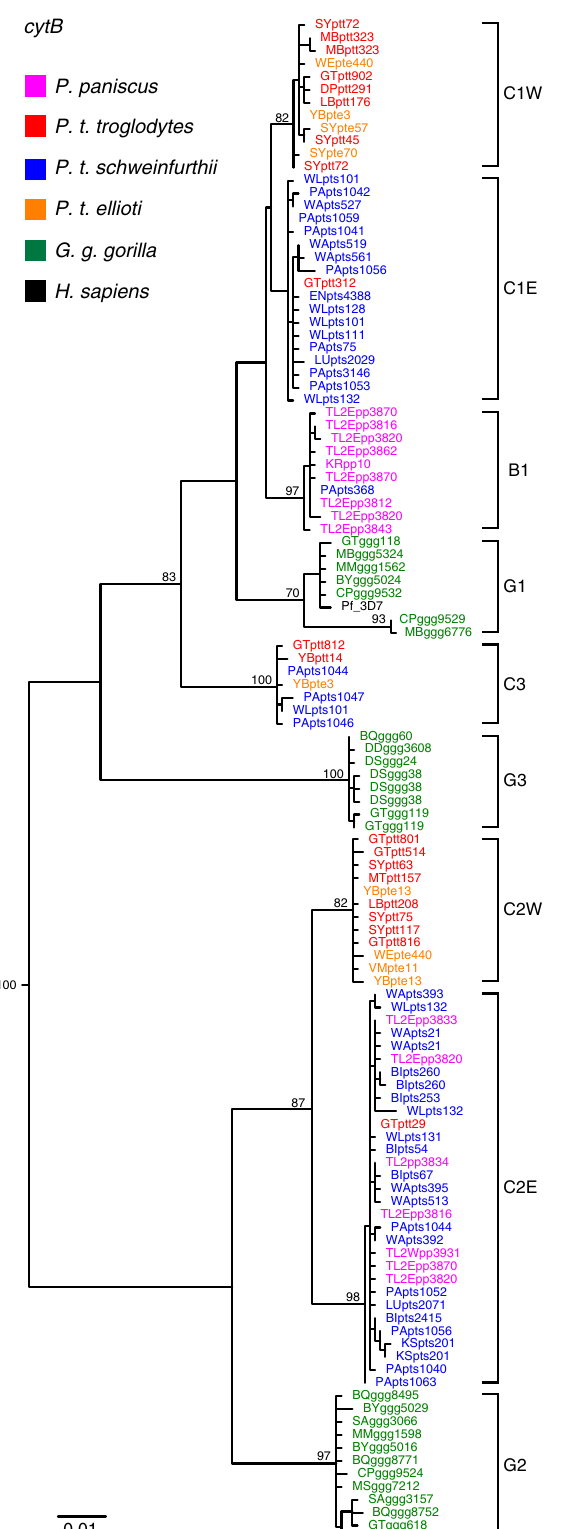
Table 3), none of the newly derived cytB sequences fell within the B1 clade (Supplementary Table 4). Instead, eastern chimpan- zees were exclusively infected with P. reichenowi (C1), P. gaboni organelle and nuclear loci for analysis (Supplementary Table 2). These included 3.4 and 3.3 kb mitochondrial DNA (mtDNA) fragments, which together span the entire mitochondrial genome; a 390 bp caseinolytic protease M ( clpM) gene fragment from the apicoplast genome; and three nuclear loci, including portions of genes encoding the erythrocyte binding antigens 165 ( eba165; 790 bp) and 175 ( eba175; 394 bp), and the gametocyte surface protein P47 ( p47; 800 bp). Phylogenetic analyses of 134 newly derived parasite sequences yielded very similar results (with respect to the clustering of parasites into major clades) in all genomic regions (Fig. 3 and Supplementary Fig. 2). Except for a single C1 eba175 sequence indicative of a rare P. reichenowi infection (Supplementary Fig. 2d), all other bonobo-derived sequences fell either within P. gaboni or the B1 clade (Supplementary Table 2). This new clade was supported by high bootstrap values in all genomic regions analysed, except for the short eba175 fragment. It also consistently grouped as a sister clade to P. reichenowi . These fi ndings, along with the extent of genetic divergence between P. reichenowi and the newly identi fi ed bonobo parasite clade, argue strongly for the existence of an additional Laverania species that is speci fi c for bonobos (Figs. 2 and 3 and Supplementary Figs. 1 and 2). The fi nding of B1 cytB (Fig. 2) and eba165 (Fig. 3a) parasite sequences in a single chimpanzee faecal sample collected 280 km east of TL2 does not argue against this, since it shows that B1 parasites reached this geographic region, but failed to spread in the resident chimpanzee population (Supplementary Table 4). We propose to name the new bonobo parasite species Plasmodium lomamiensis sp. nov. to highlight its discovery in Lomami National Park, using faecal-derived mitochondrial, apicoplast and nuclear parasite sequences as the type material (Supplementary Data 1) 19 . Although classifying ape Laverania species solely on the basis of genetic information has been controversial 3,17,20 , there are no obvious alternatives given the endangered status of wild apes, the prevalence of mixed Laverania species infections (Supplementary Table 2) and the cryptic nature of these parasites 3,9,21 . Fig. 2 Relationship of bonobo parasites to ape Laverania species. A maximum likelihood tree of mitochondrial cytochrome B ( cytB ) sequences (956 bp) depicting the phylogenetic position of newly derived bonobo parasite sequences (magenta) is shown. Only distinct cytB haplotypes are depicted (the full set of SGA-derived bonobo parasite sequences is shown in Supplementary Fig. 1). Sequences are colour-coded, with capital letters indicating their fi eld site of origin (see Fig. 1 for location of fi eld sites) and lowercase letters denoting their host species and subspecies origin (ptt: P. t. troglodytes , red; pte: P. t. ellioti , orange; pts: P. t. schweinfurthii , blue; ggg: G. g. gorilla , green; pp: Pan paniscus , magenta). C1, C2 and C3 represent the chimpanzee parasites P. reichenowi , P. gaboni and P. billcollinsi ; G1, G2 and G3 represent the gorilla parasites P. praefalciparum, P. adleri and P. blacklocki (the P. falciparum 3D7 reference sequence is shown in black). P. reichenowi (C1) and P. gaboni (C2) mitochondrial sequences are known to segregate into two geographically de fi ned subclades according to their collection site in 'western' (W) or 'eastern' (E) Africa 3 . Bonobo parasite sequences (magenta) cluster with P. gaboni from eastern chimpanzees (C2E), but also form a new clade, termed B1. The tree was constructed using PhyML 58 with TIM2+I+G as the evolutionary model. Bootstrap values are shown for major nodes only (the scale bar represents 0.01 substitutions per site) NATURE COMMUNICATIONS | 8: 1635 | DOI: 10.1038/s41467-017-01798-5 |